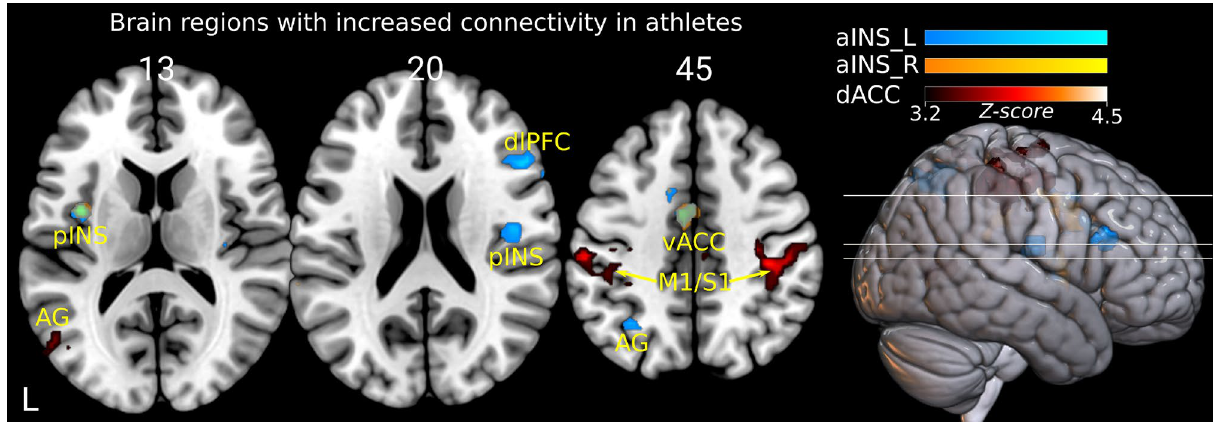
Figure 1. Group differences between athletes and non-athletes in functional connectivity for aINS_L, aINS_R, and dACC seeds. All identified brain regions indicate significantly increased rsFC in athletes compared to non-athletes. The cool, warm and red colormaps illustrate the magnitude of the statistical significance (Z-score) in each voxel, where brighter color means higher Z-score. The light green color found in pINS and vACC regions occurs due to the overlapping in these areas of the cool and warm colormaps from aINS_L and aINS_R, respectively. aINS_L—left anterior insula, aINS_R—right anterior insula, dACC—dorsal anterior cingulate